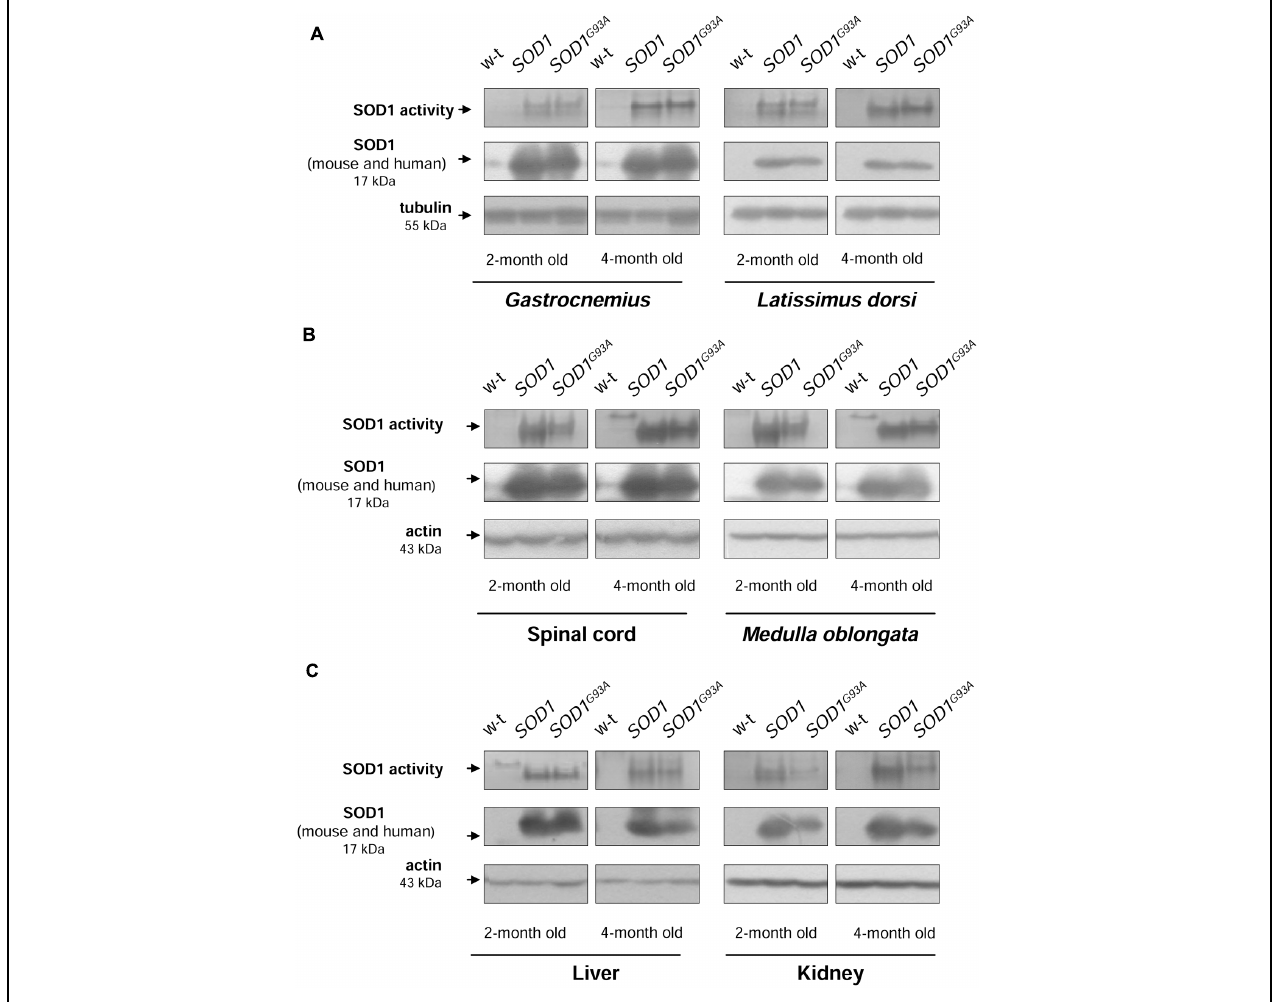
FIGURE 1 | CuZn-SOD1 (SOD1) activity and expression in tissues of experimental mice. In-gel activity staining for SOD1 activity in total protein extracts obtained from skeletal muscles (A) , neuronal tissues (B) , liver, and kidney (C) (upper). Results of Western blot analysis of SOD1 in the same protein extracts are shown in (middle). Blots were also re-probed with monoclonal anti-tubulin or anti- β -actin antibodies from mouse as a loading control (lower). Data are representative for three independent Western blot analyses performed using extracts from 3 mice of each experimental group. The intensity of the SOD1 bands (relative to the intensity of tubulin or actin bands) was quantified with a Molecular Imager using Quantity One software (Bio-Rad) and is shown in arbitrary units to present protein level (Supplementary Table). Results are expressed as mean ± SD for three mice in each experimental group. Significant differences ( P < 0.01) in SOD1 protein levels were found between transgenic ( SOD1 and SOD1 G 93 A ) and wild-type mice in a given tissue and age